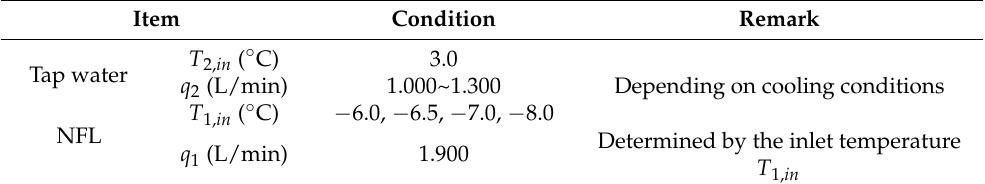
Table 2. Experimental